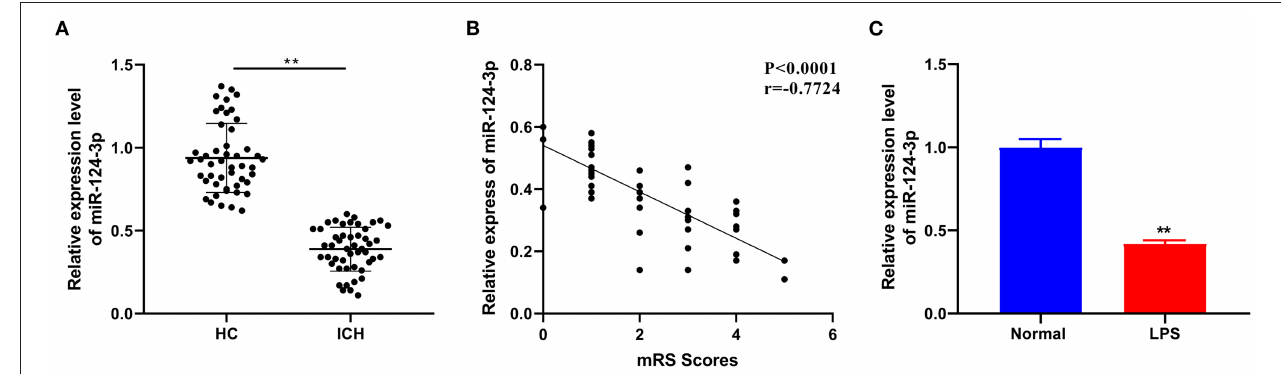
FIGURE 1 | miR-124-3p was downregulated in microglia after ICH. (A) The expression of miR-124-3p in the serum of patients with primary ICH in the basal ganglia was detected using RT-qPCR, N = 48; (B) Pearson was used to analyze the correlation between the expression of miR-124-3p and the modified Rankin Scale (mRS) score 3 months after ICH; (C) The expression of miR-124-3p in LPS-induced microglia and normal microglia was detected using RT-qPCR. The cell experiment was repeated three times independently. Data are expressed as mean ± standard deviation. Data in panels A/C were analyzed using t -test, ** p <